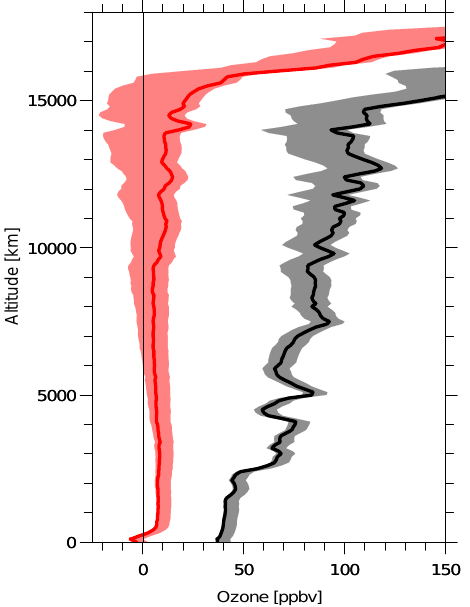
Fig. A1. Tropospheric ozone profiles at 33.5 ◦ N (black, 11 October) and at 10.5 ◦ N (red, 16 October). The shading illustrates the effect of different assumptions on the evolution of the background current during the sounding on the ozone mixing ratios calculated from the cell current. The lowest values (left hand edge of the shading) result from subtracting a constant background current, the highest values (right hand edge) from assuming that the background current drops to zero immediately after the launch, i.e., from not subtracting any background. The lines reflect the results from subtracting a pressure dependent background current (see